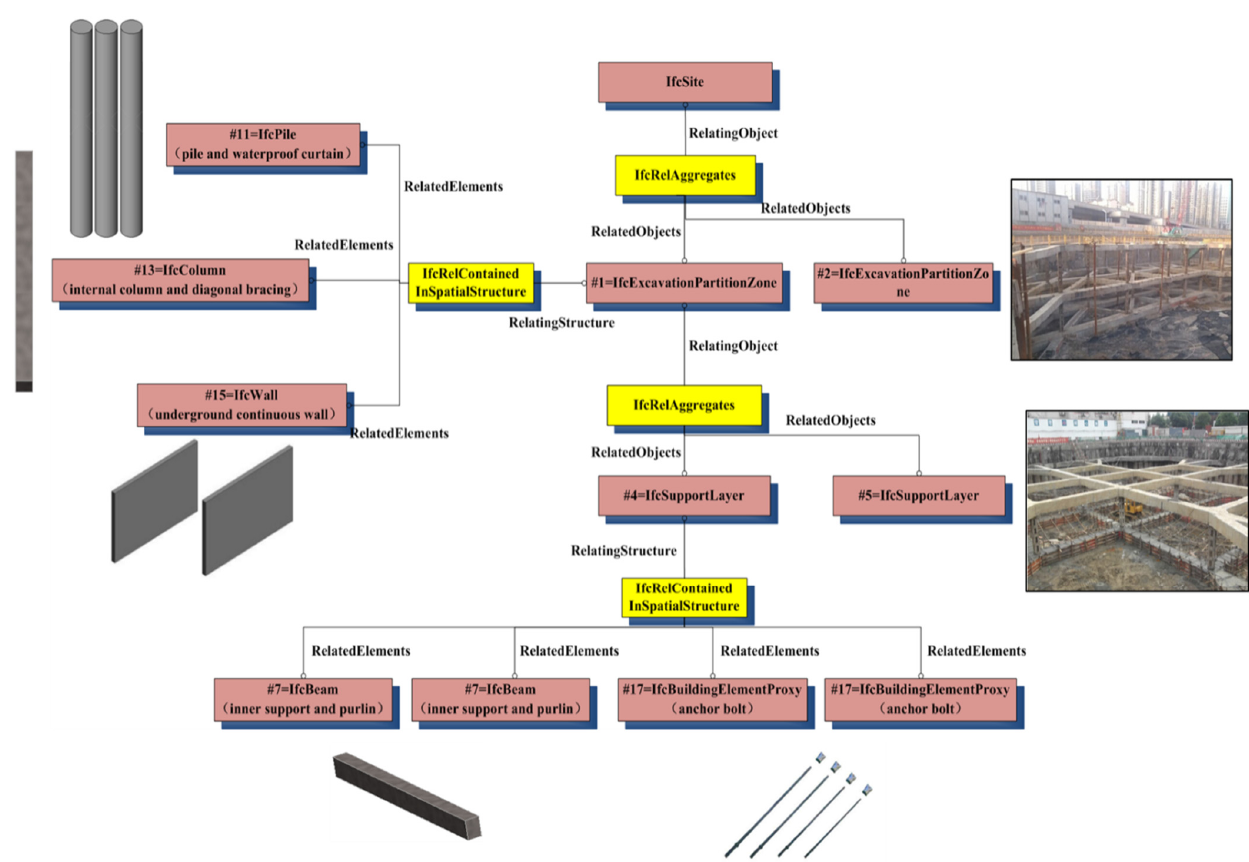
Figure 8. Relationships between spatial and structure component entities in deep excavation engineering.